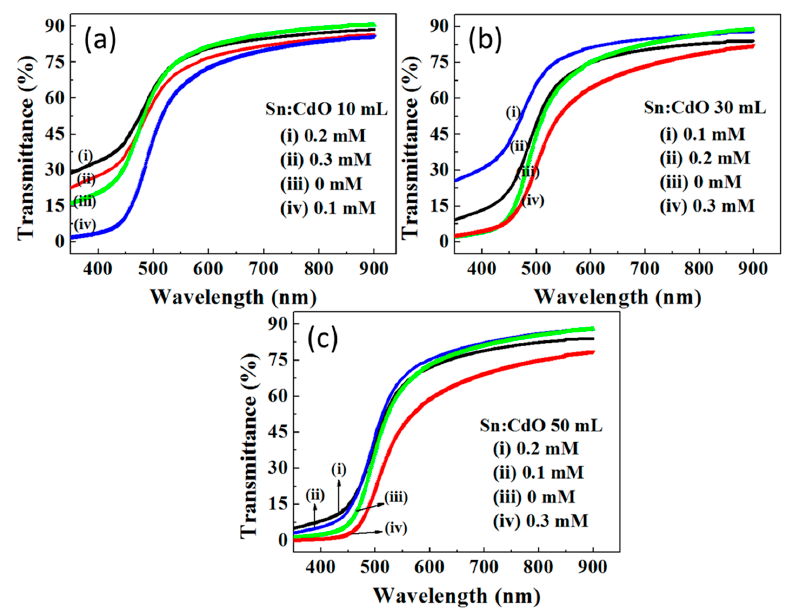
Figure 6. UV-Vis transmittance spectra of CdO films with different Sn-doping concentrations and volumes. Table 2. Comparison of the transmittance values of un-doped CdO and Sn:CdO with various volumes (mL) and concentrations at different wavelengths ( λ ) .